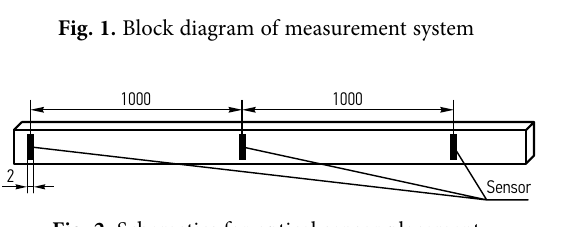
Fig. 2. Schematics for optical sensor placement